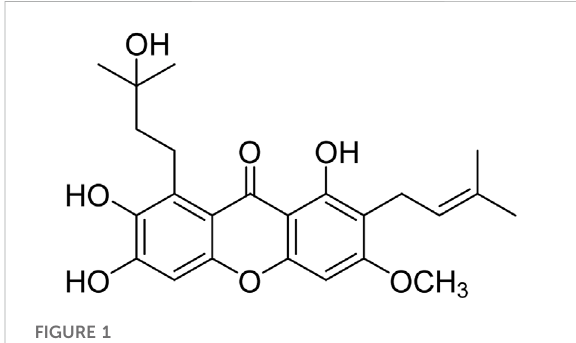
FIGURE 1 Chemical structure of cratoxylumxanthone